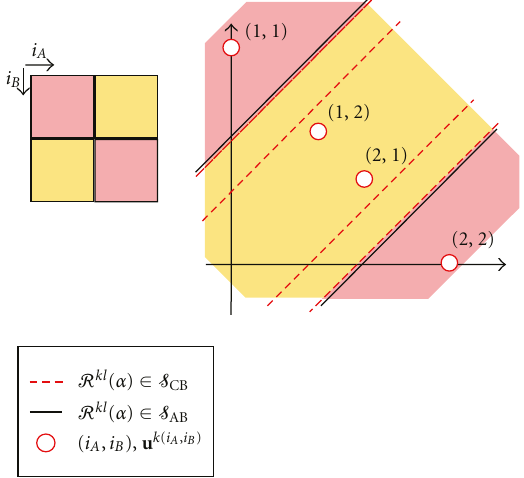
Figure 5: HDFD decision regions’ shape example (real-valued 2-dimensional example codebook). Note that some boundaries lie inside the decision region corresponding to one hierarchical codeword (given by the same region colour). Such boundaries do not a ff ect the final decision region’s shape, and hence can be considered as